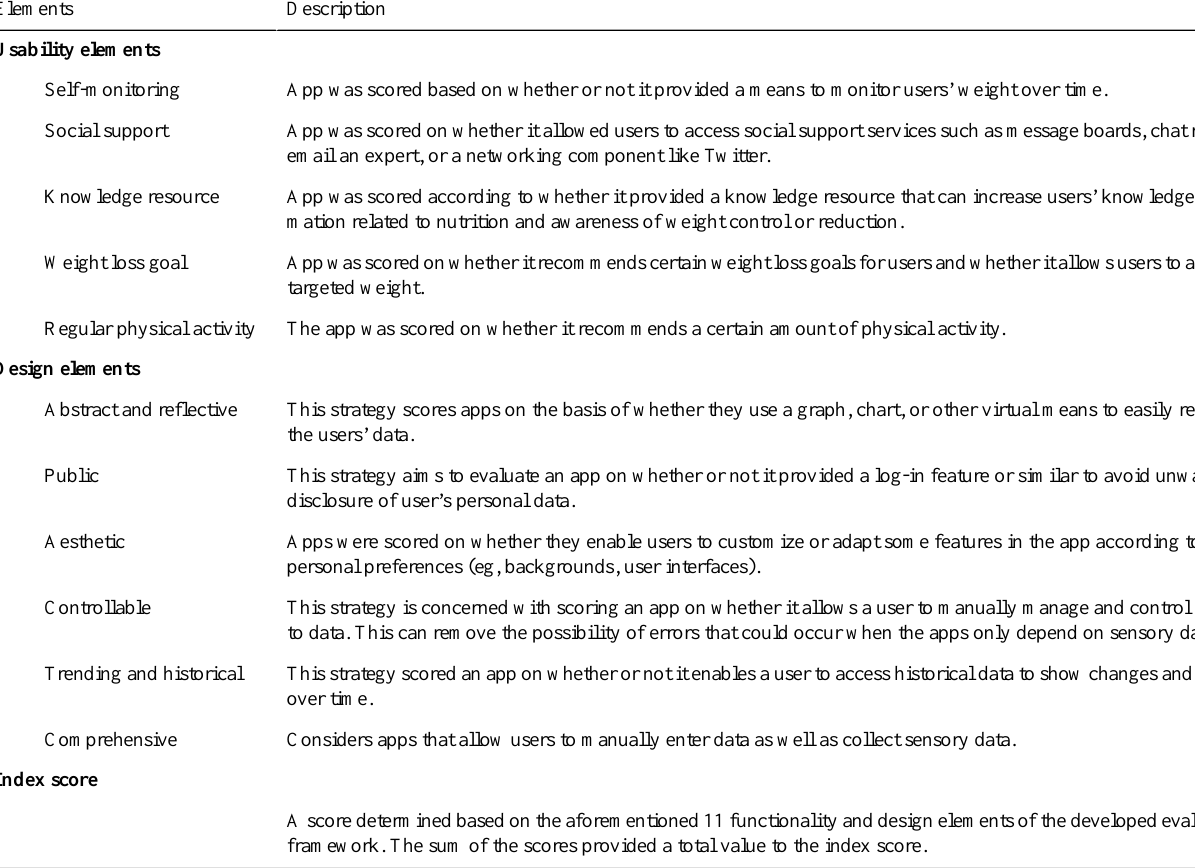
Table 1. Elements of the developed weight loss and diet evaluation